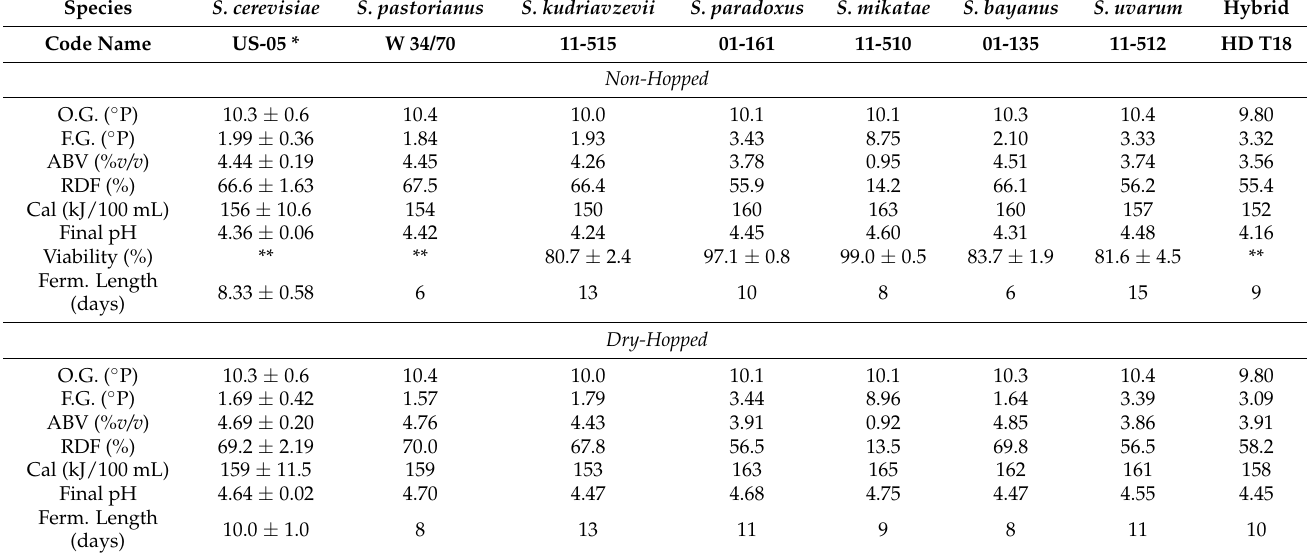
Table 3. Terminal fermentation characteristics of Saccharomyces species and reference strains used to ferment all-malt wort at 40.0 L pilot scale under two different conditions: non-hopped or dry-hopped during fermentation. Measurements of original gravity (O.G.), final gravity (F.G.) as % w/w of apparent extract, alcohol by volume (ABV), real degree of fermentation (RDF), and calories (Cal) performed on Anton Paar Alcolyzer Beer M. Viability was performed from cells in suspension on non-hopped beers on day of terminal gravity, stained with methylene blue, as per standard procedure (69). Viability was not performed on dry-hopped beers due to interference from hops in suspension. Fermentation length as given in days to achieve final gravity. Strain listed as “Hybrid” is the HDT18 interspecies hybrid of S. bayanus x S. cerevisiae from LeSaffre R&D. US-05 analytical control is listed with standard